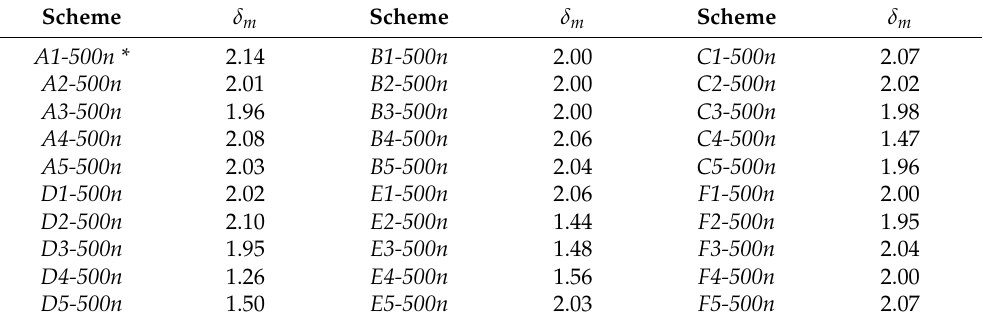
Table A2. A full list of the final δ m values of the substrates that were treated with different schemes shown in Table 1 before 500 nm-thick gold